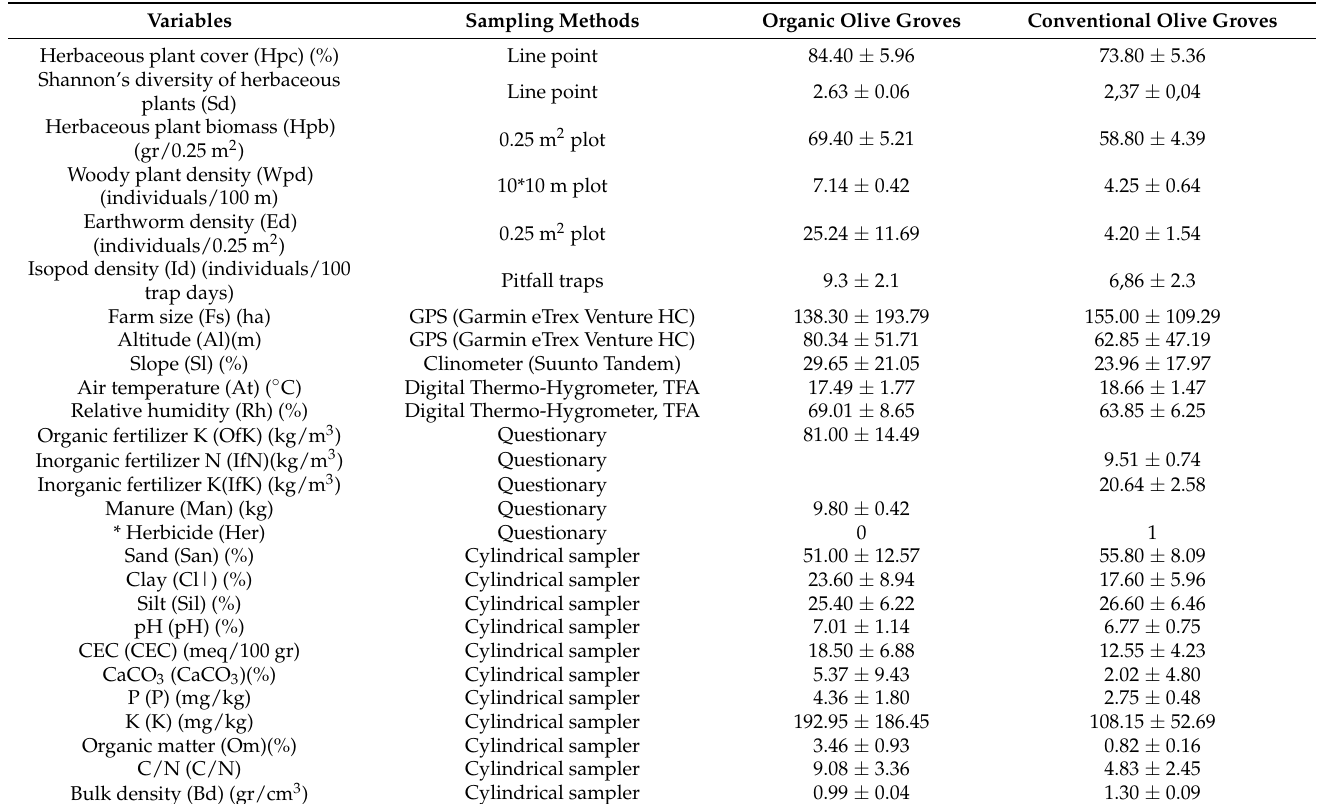
Table A1. Mean ( ± Standard Deviation) of agricultural and environmental factors in organic and conventional olive groves. Variables Sampling Methods Organic Olive Groves Conventional Olive